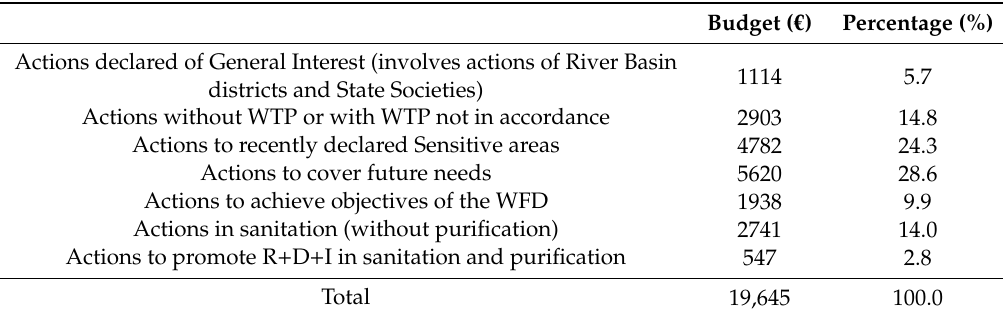
Table 2. Planned actions, and their economic valuation, in the National Water Quality Plan: Sanitation and Water Treatment 2007–2015 (PNCA). Source: